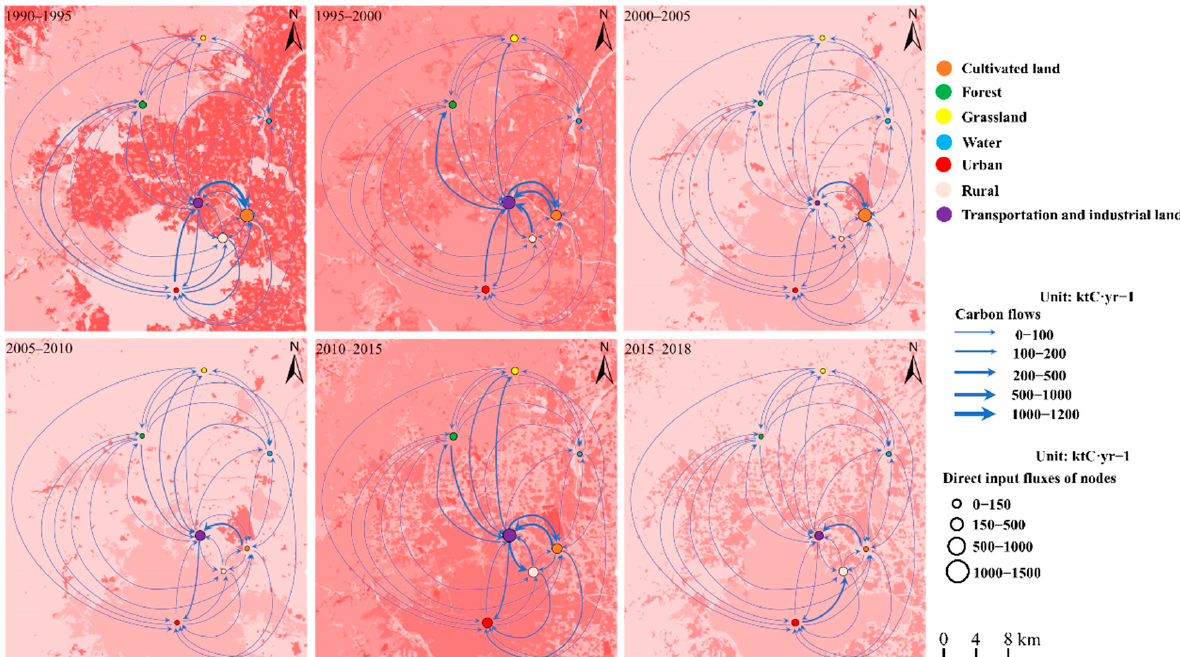
Figure 3. Spatial distribution of direct carbon flows in each period (the flows that are shown account for at least 80% of the total flows). Note: the flows related to bare land were too small to show in the figure.